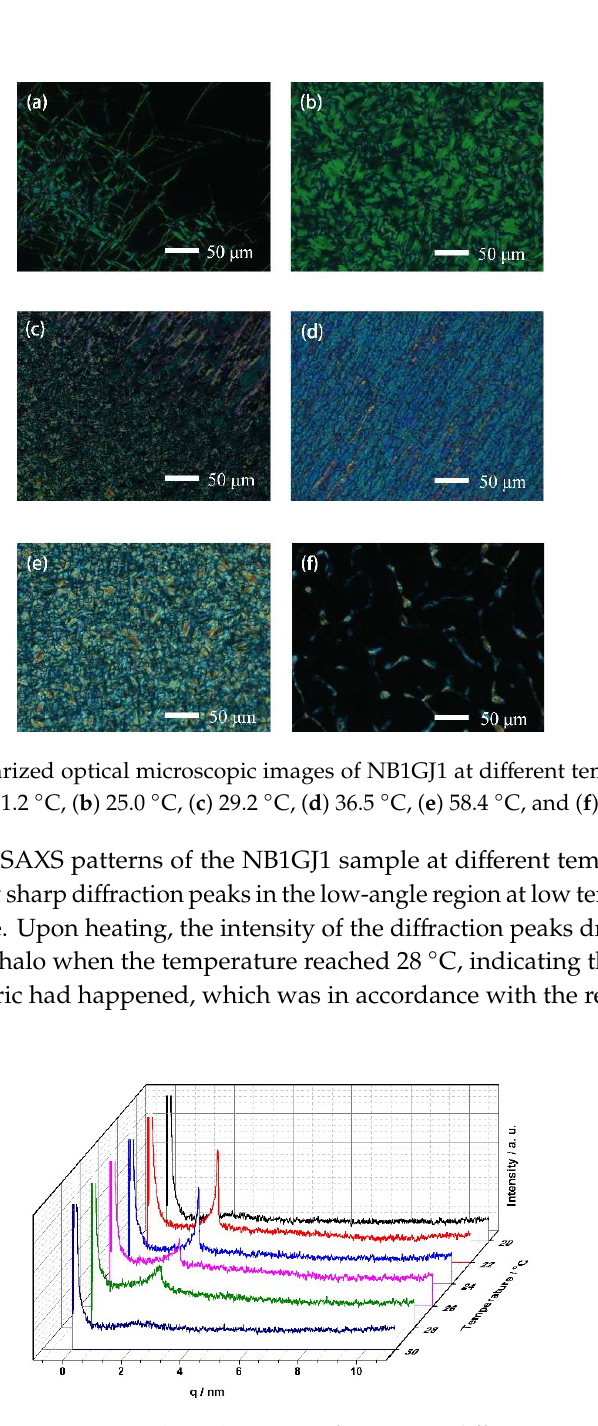
Figure 3. Small-angle X-ray scattering (SAXS) patterns of NB1GJ1 at different temperatures during the heating process.